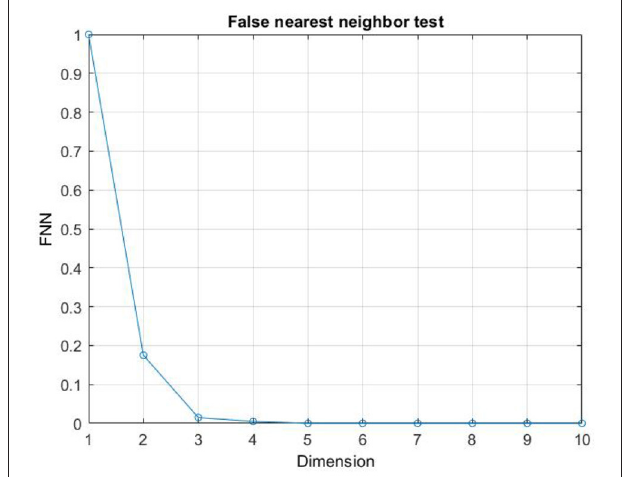
FIGURE 5 | Example of the computation of the Embedding dimension m . FIGURE 6 | Example of the computation of the Time delay τ